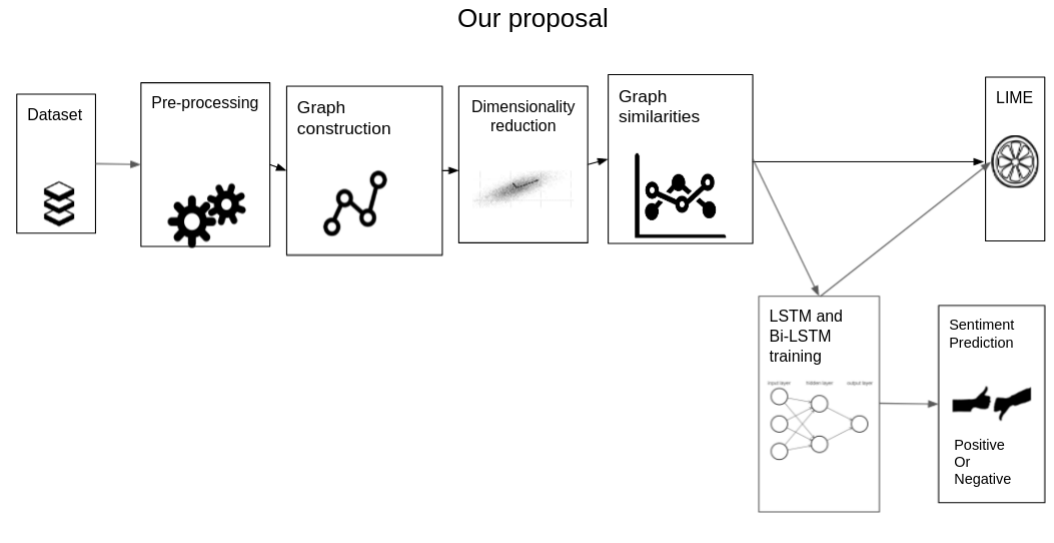
Figure 4. Pipeline that represents the proposal’s